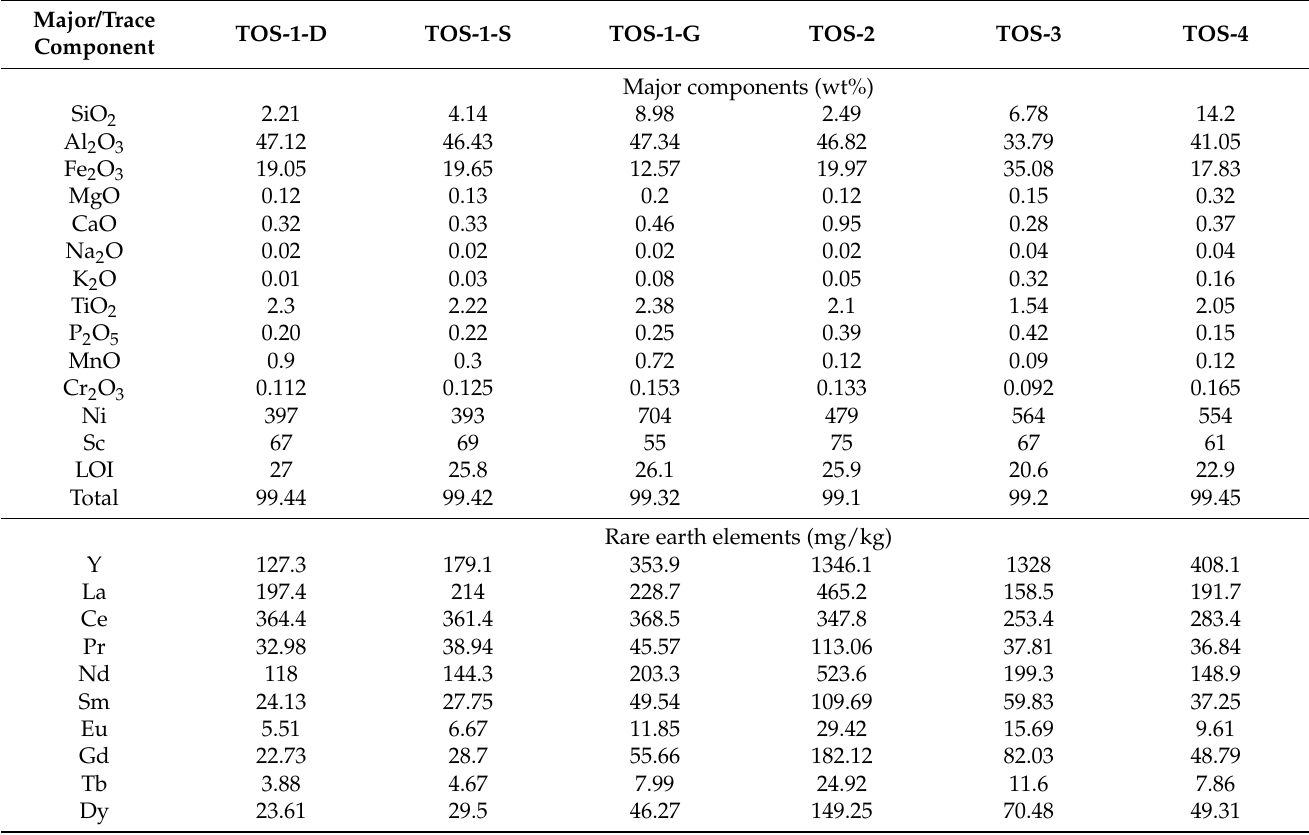
Table 2. Chemical composition of the bauxite samples from Toši´ci-Duji´ci (major components in wt%; Ni, Sc, REE in mg/kg) together with REE fractionation values (Ce/Ce*, Eu/Eu*, and La/Yb). Major/Trace